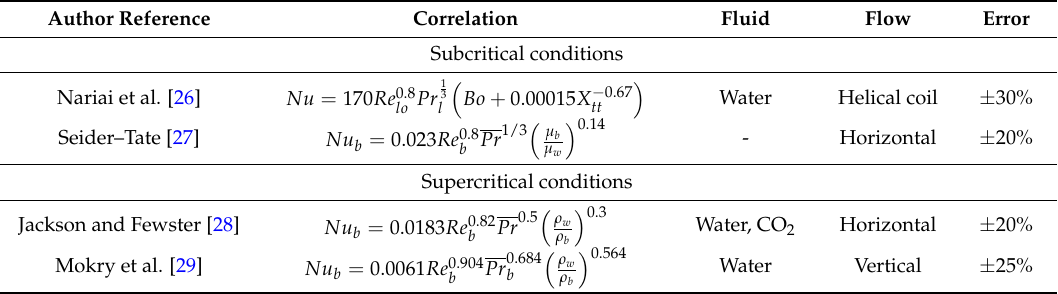
Table 4. Heat transfer correlations used for the comparison with the experimental Nusselt (Nu)